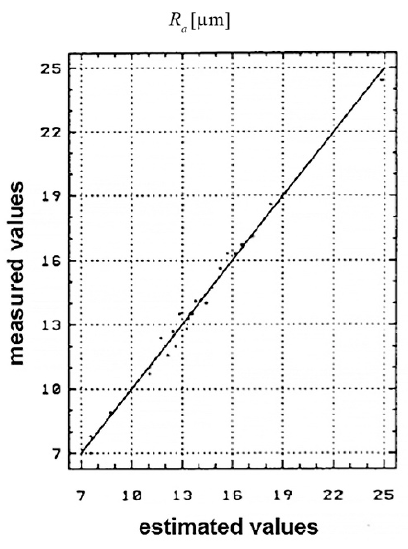
Figure 12. R a measured values [µm].